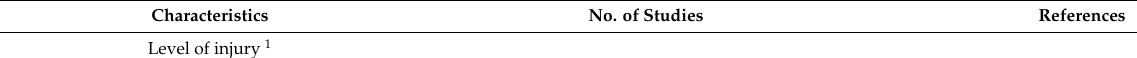
Table 1. Characteristics of studies included in the